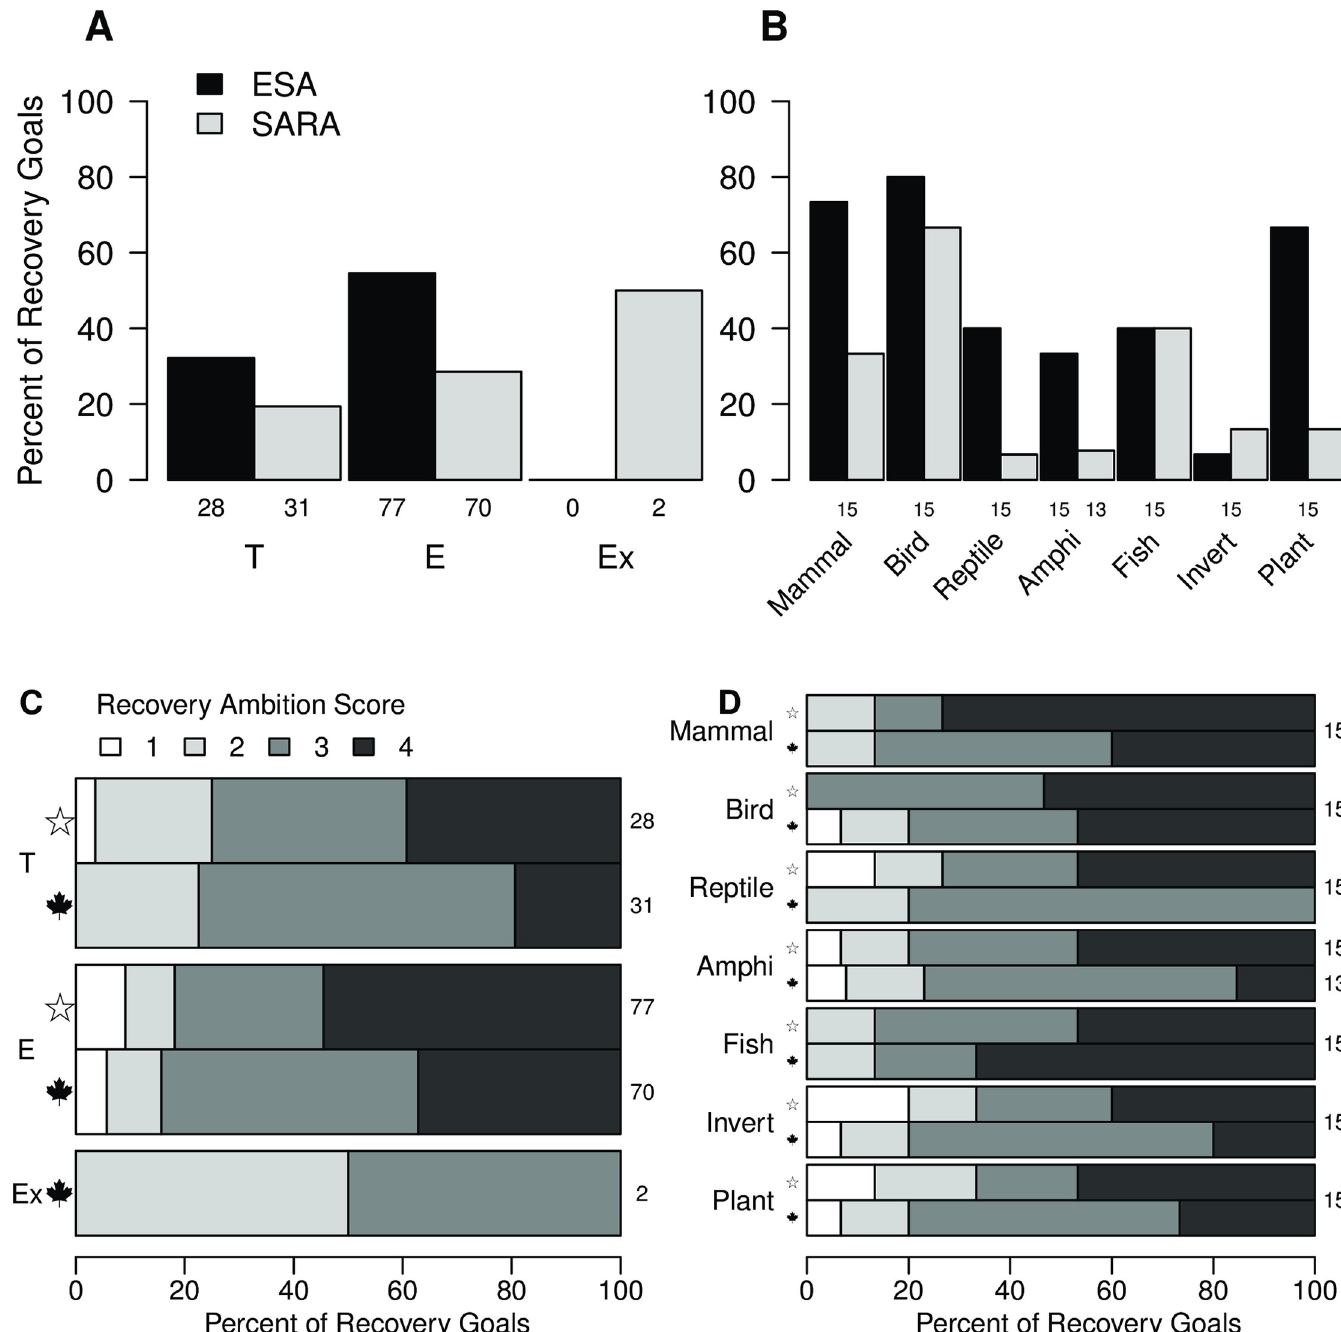
Fig 2. Quantitativeness and ambition of recovery goals for species (n = 208) listed under both the United States’ Endangered Species Act (ESA) and Canada’s Species at Risk Act. Percent of quantitative recovery goals (A) by species status (i.e., threatened [T], endangered [E], or extirpated [Ex]), and (B) by natural grouping. Ambition of recovery goals listed under the ESA (denoted by a star) and SARA (denoted by a maple leaf) (C) by status and (D) natural grouping, Ambition of recovery goals within published recovery documents was scored on a scale from 1 to 5; however, no goals received an ambition score of 5 (see Methods). Sample sizes are displayed to the right of